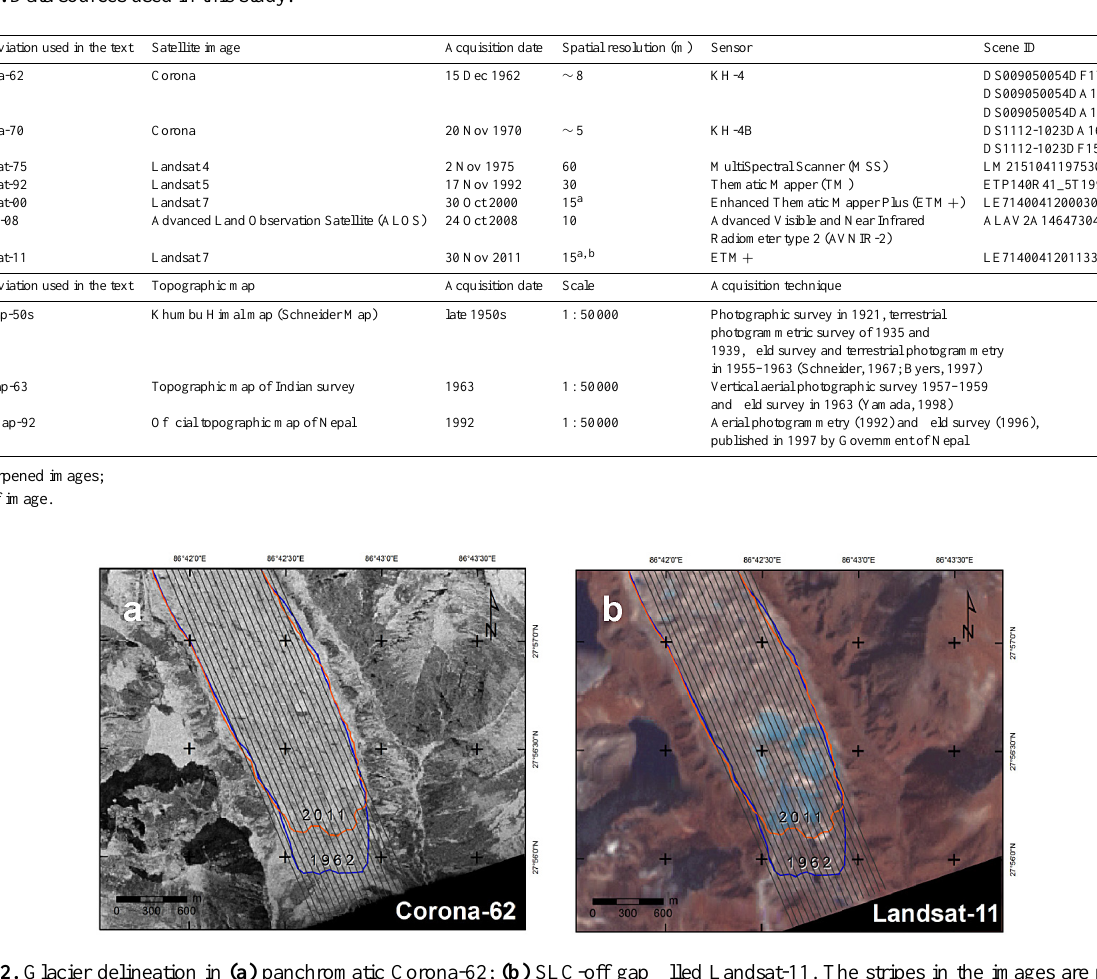
Table 1. Data sources used in this study.